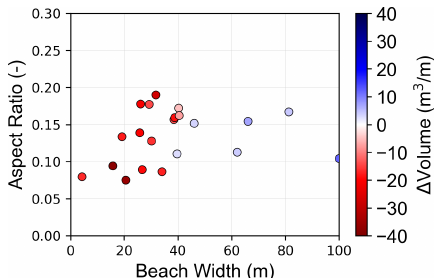
Figure 13. Pre-storm aspect ratio versus pre-storm beach width for foredunes at Bogue Banks, NC. Each point represents a transect and points are colored based on the change in volume from